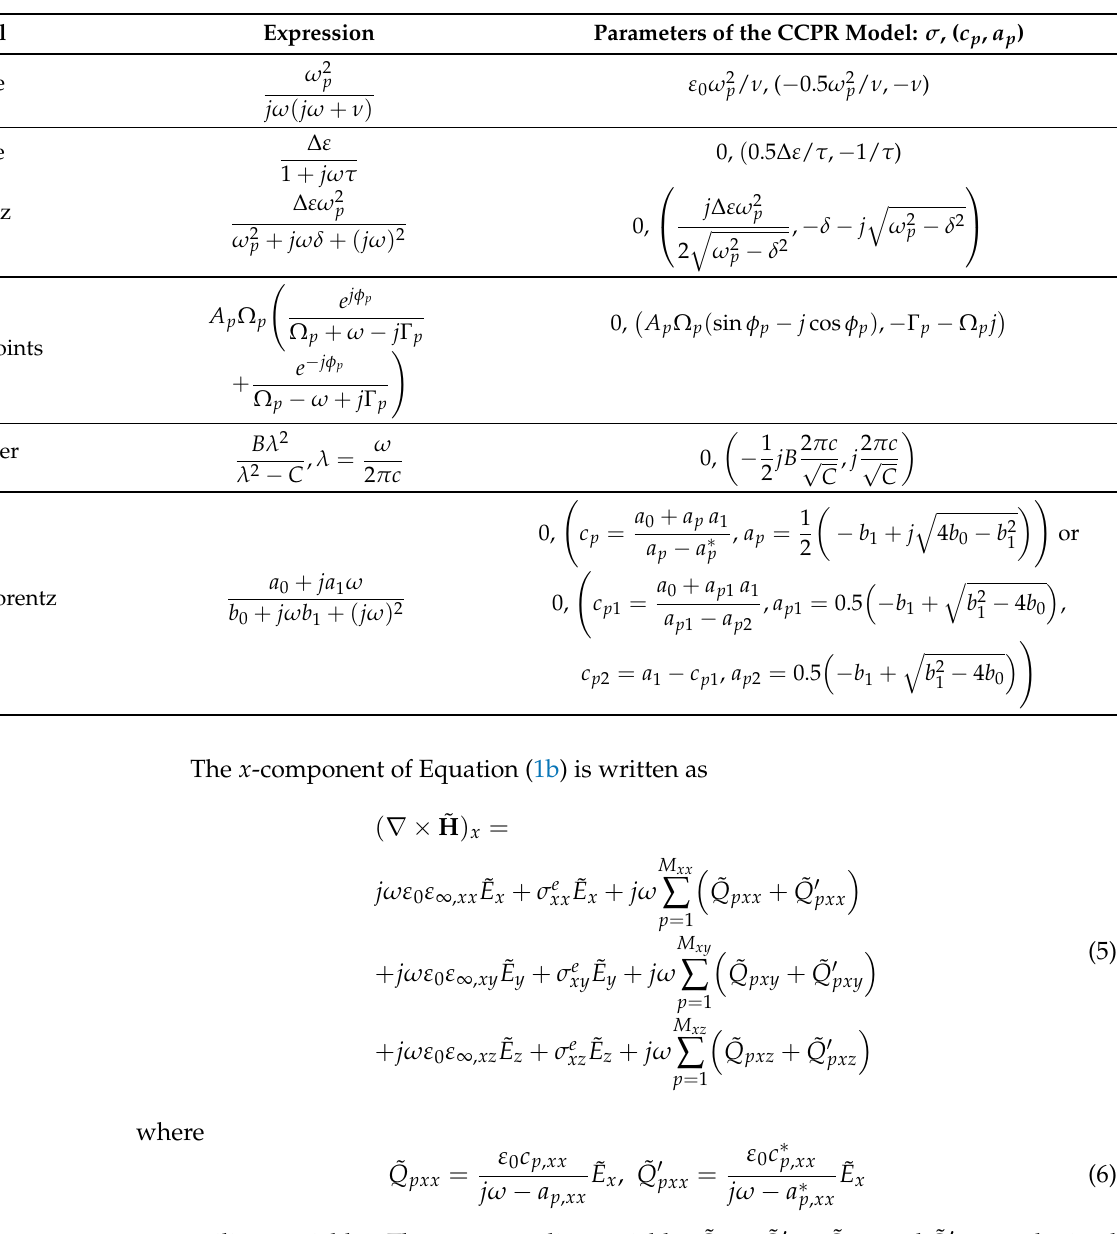
Table 1. CCPR parameters for the description of various known dispersion